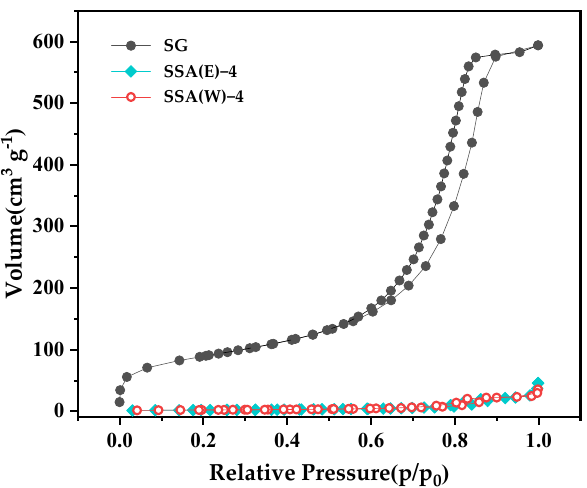
Figure 3. N 2 adsorption/desorption isotherms of SG, SSA(E) − 4 and SSA(W) − 4.